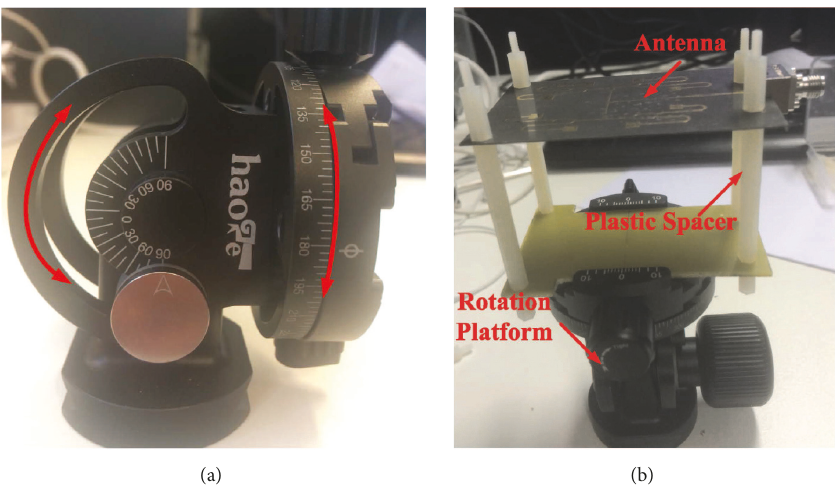
Figure 11: (a) The rotation platform and (b) the installation of antenna in the platform.